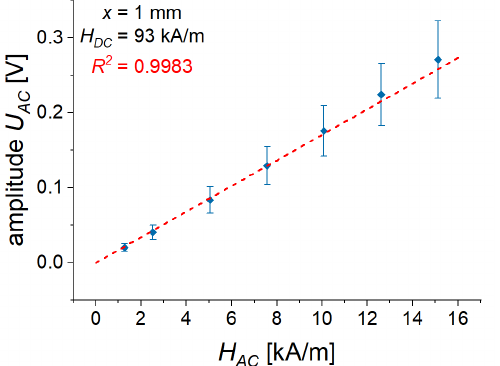
Figure 14. Dependence of the AC voltage amplitude U AC on the amplitude H AC of AC magnetic field. R 2 denotes the determination coefficient of the linear